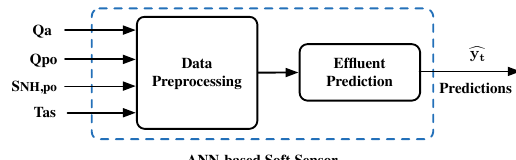
Figure 3. Artificial neural network (ANN)-based soft sensor. Predictions ( ( S NH , e ) or total nitrogen ( S Ntot , e ) concentrations.